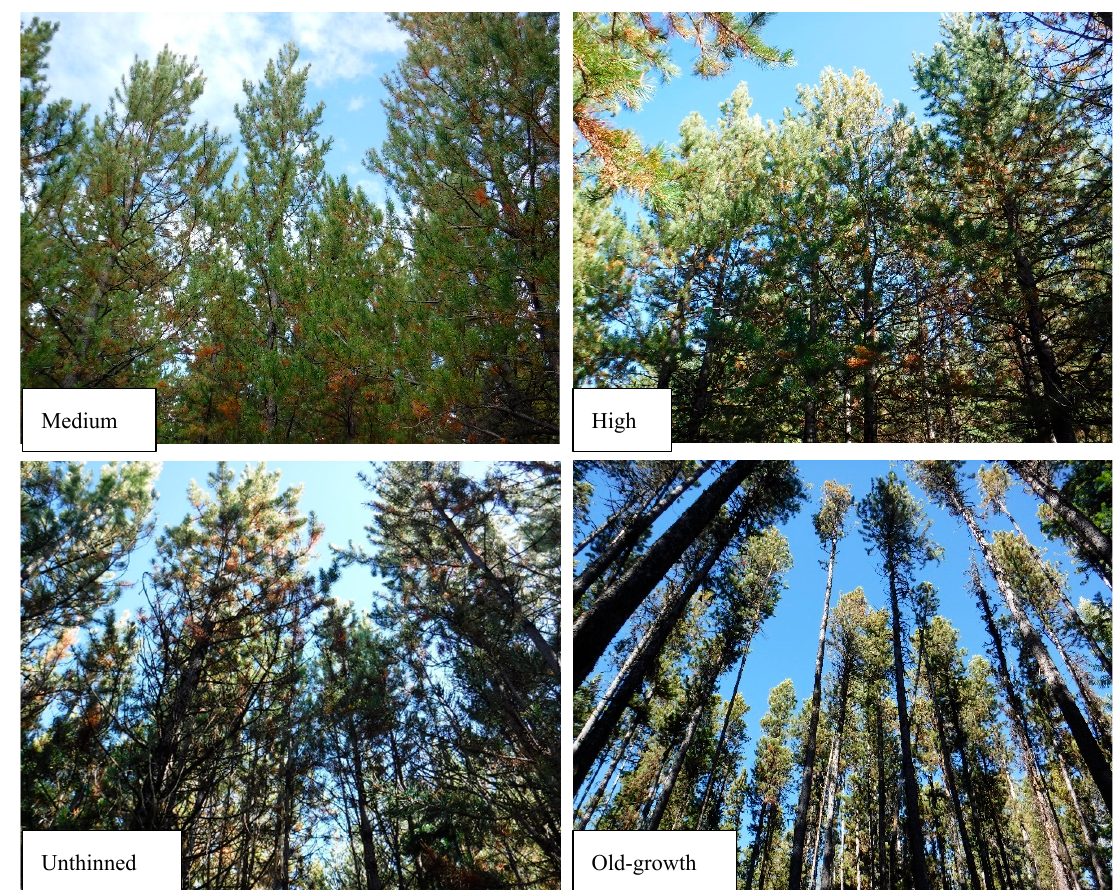
Figure 2. Photographs of crowns of lodgepole pine stands: four densities of thinned, an unthinned stand, and an old-growth stand at Summerland in summer 2018, 25 years after initiation of treatments.